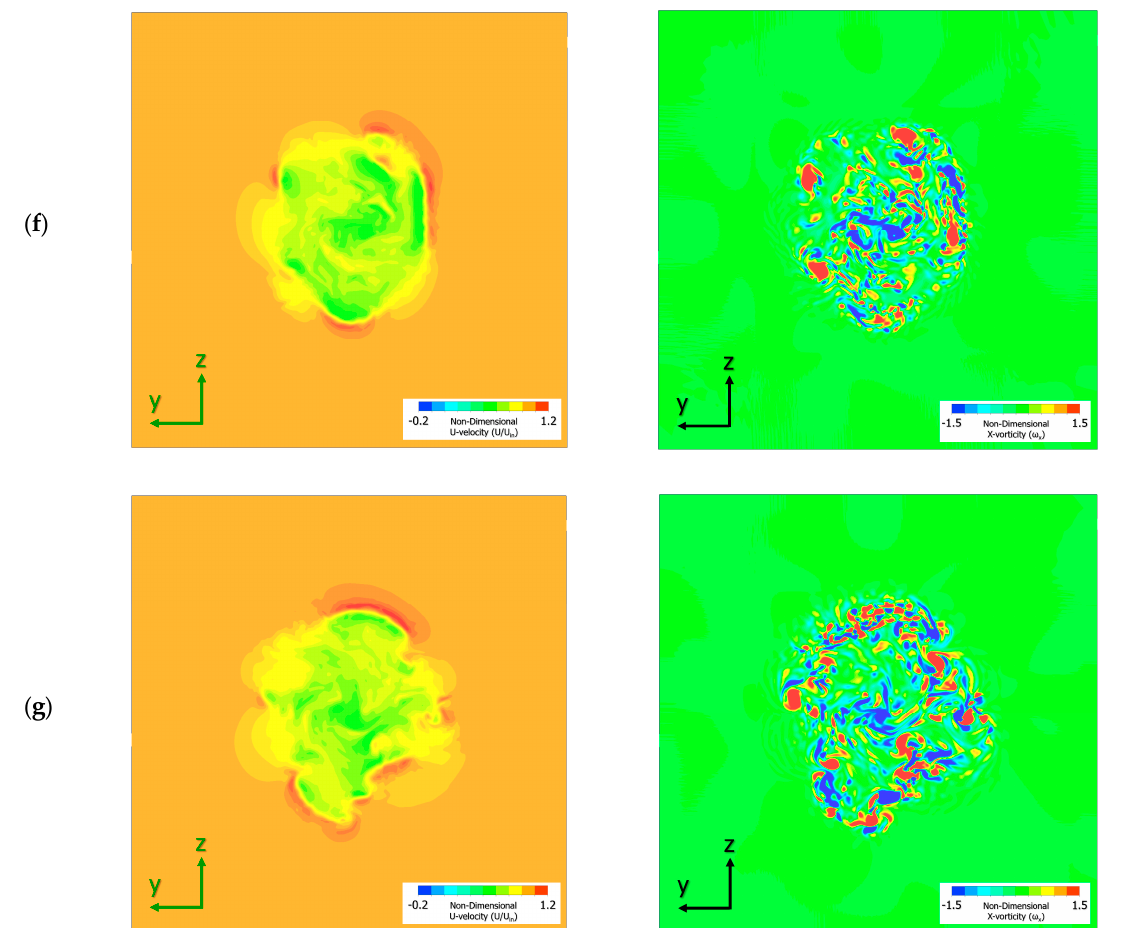
Figure 7. Spatial distribution of U-velocity and vorticity for instantaneous flow field: ( a ) x–y plane (top view), ( b – g ) y–z plane (rear view): ( b ) x = 0.5 D, ( c ) x = 1.0 D, ( d ) x = 2.0 D, ( e ) x = 4.0 D, ( f ) x = 6.0 D, and ( g ) x = 8.0 D.